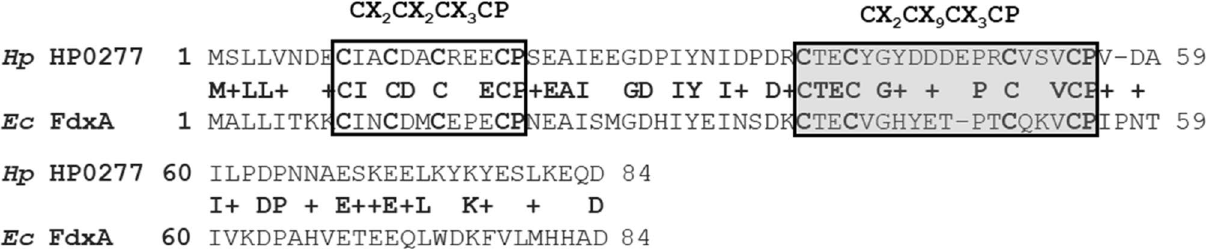
Figure 2. Sequence alignment of H. pylori HP0277 and E. coli Fdx. H. pylori HP0207 shares 45% identity and 64% similarity with E. coli Fdx. A conserved ferredoxin CX 2 CX 2 CX 3 C(P) motif is shown in the white box